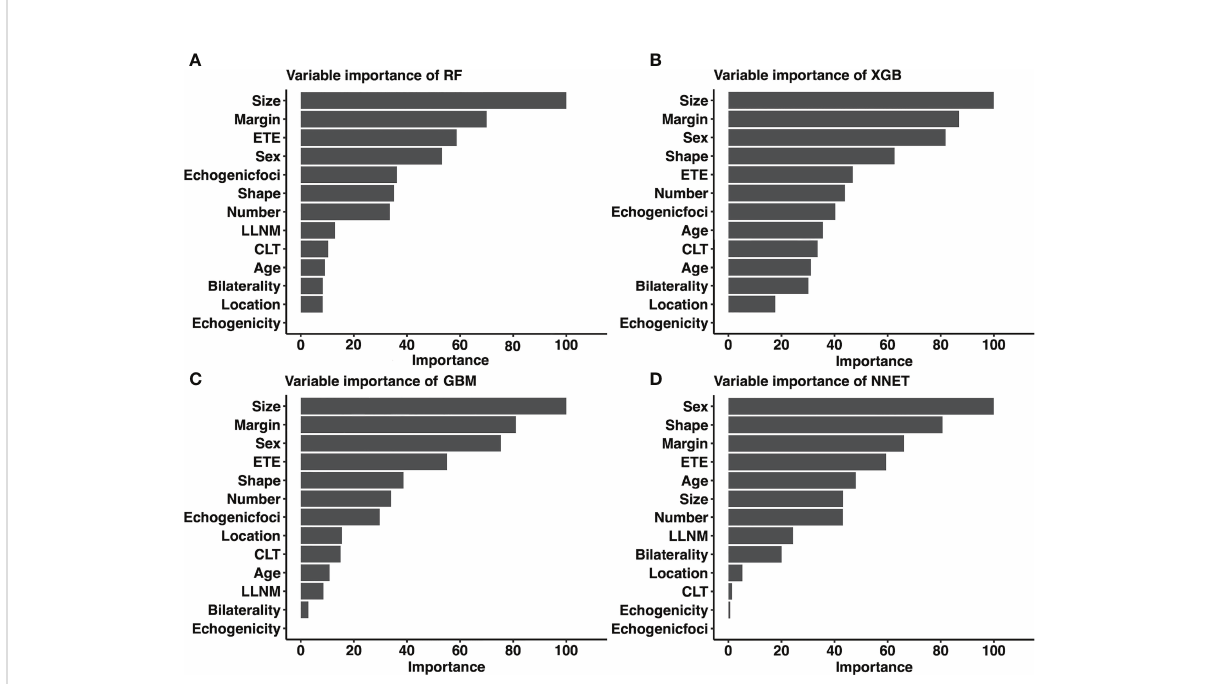
FIGURE 5 Relative importance ranking of each input variable for prediction of CLNM in the machine learning models. (A) RF model; (B) XGB model; (C) GBM model; (D) NNET model. CLNM , Central lymph node metastasis; ETE , extrathyroidal extension; LLNM , lateral lymph node metastasis; CLT , chronic lymphocytic thyroiditis; RF , Random Forest; XGB , Extreme Gradient Boosting; GBM , Gradient Boosting Machine; NNET , Neural